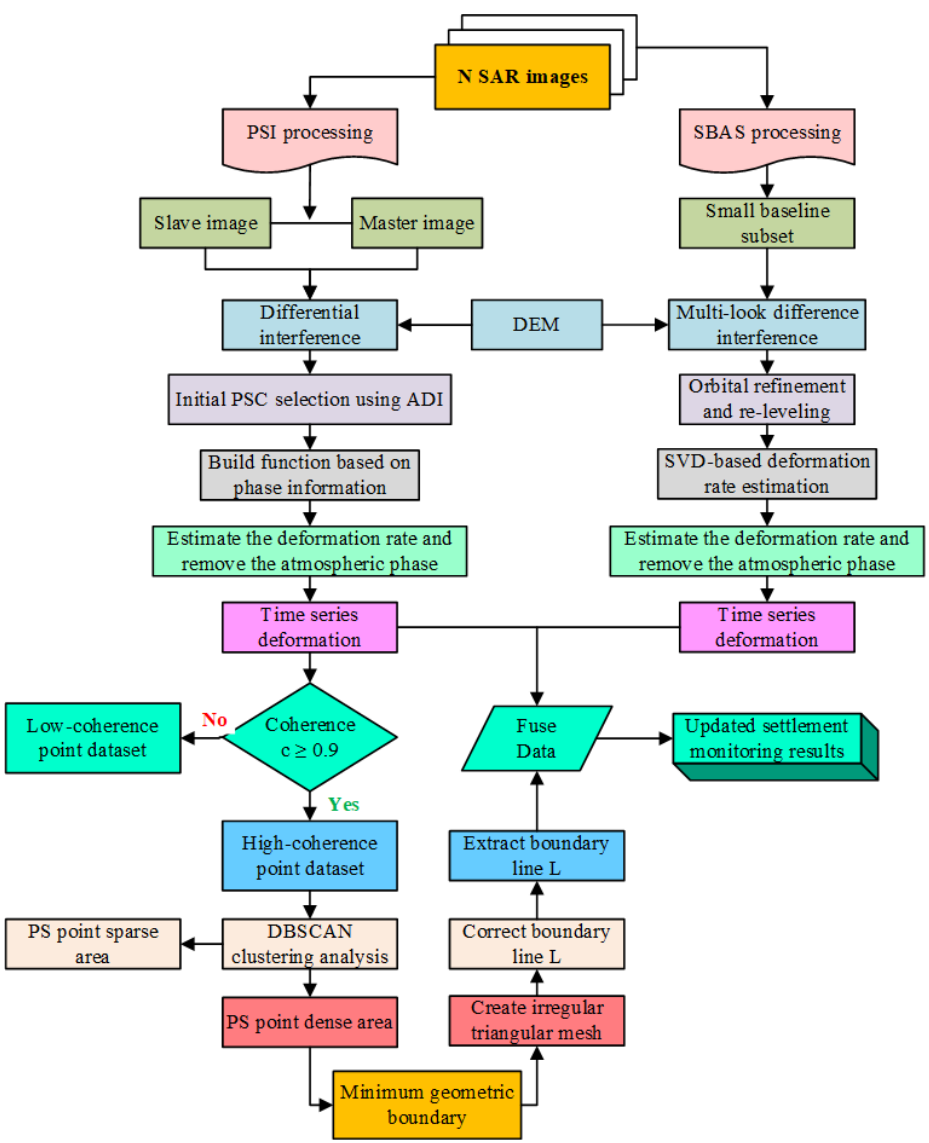
Figure 1. Flowchart of the proposed